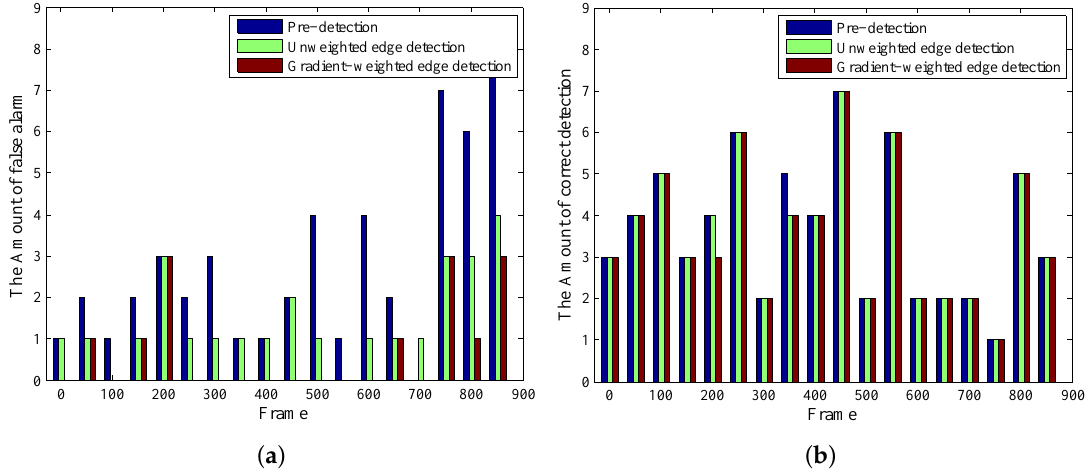
Figure 10. Statistics of the amount of ( a ) False alarm. ( b ) Correct detection. One point is taken every 50 frames for image quality. Table 1 lists out the comparison result of 3 false alarm reduction methods: method via median